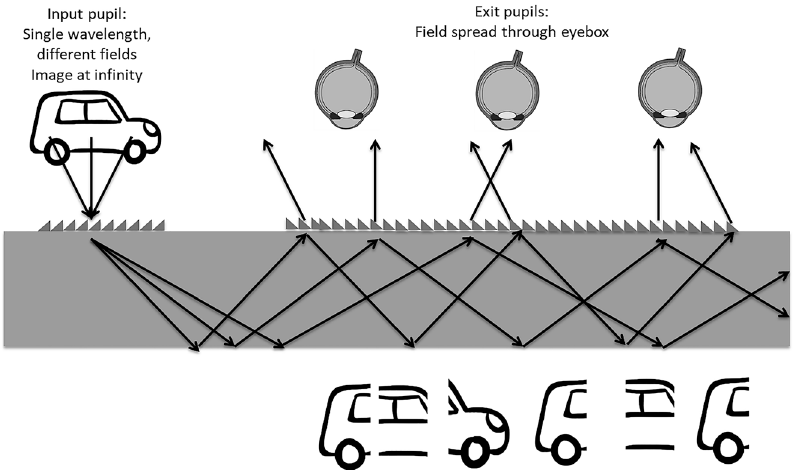
Figure 24: Fractional field spread in a waveguide